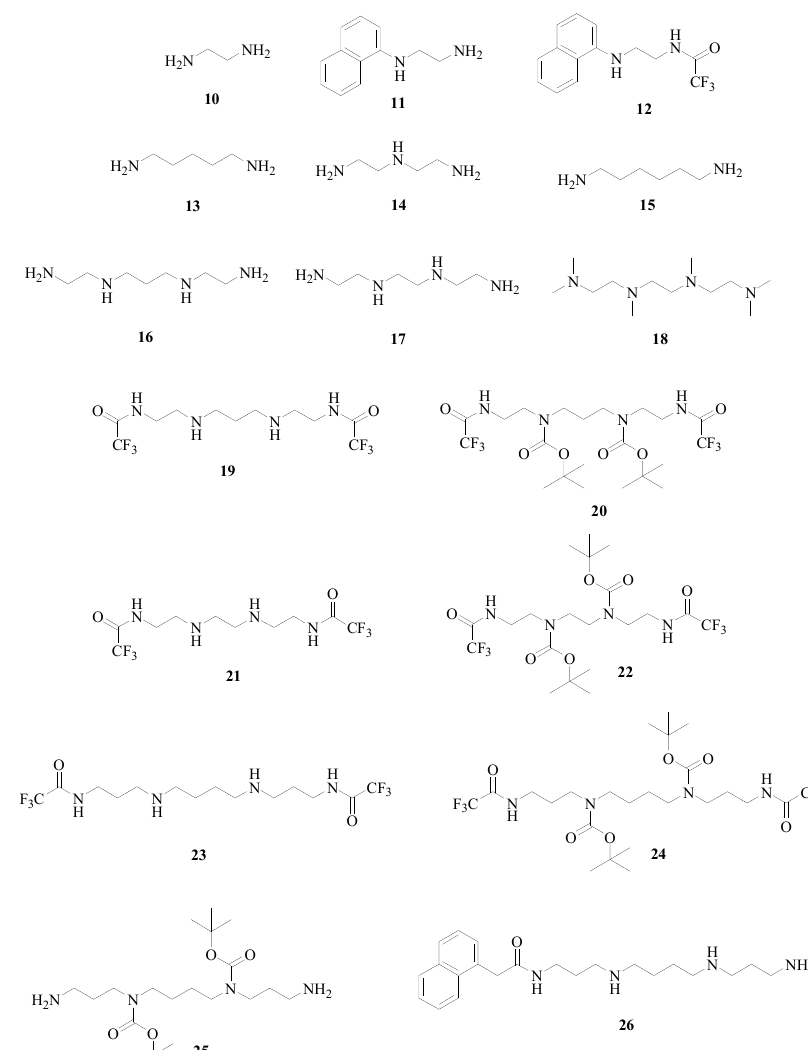
Figure 5. Series of synthetic polyamine derivatives 10 – 26 tested against the α -CAs [10].